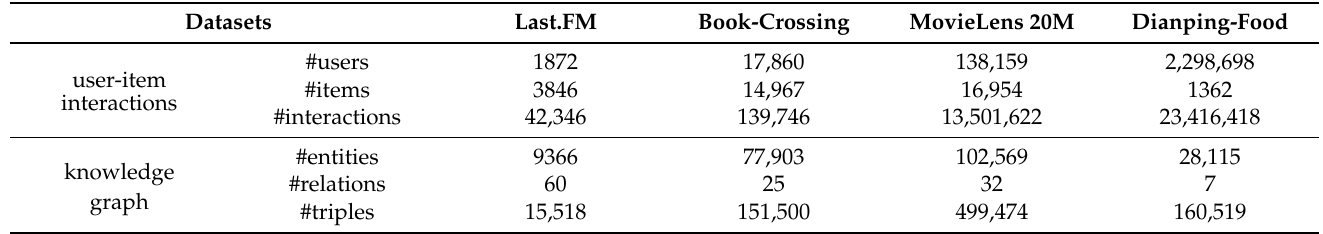
Table 1. Statistics of the experimental datasets and their corresponding knowledge